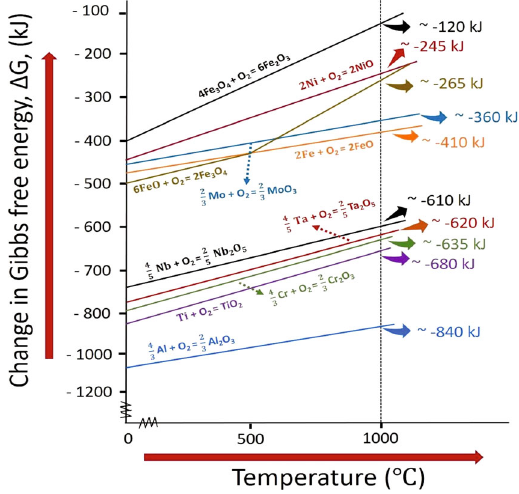
Fig. 2 Ellingham diagram for metals. Ellingham diagram for the oxidation reactions of metallic constituents of IN718 14 – 16